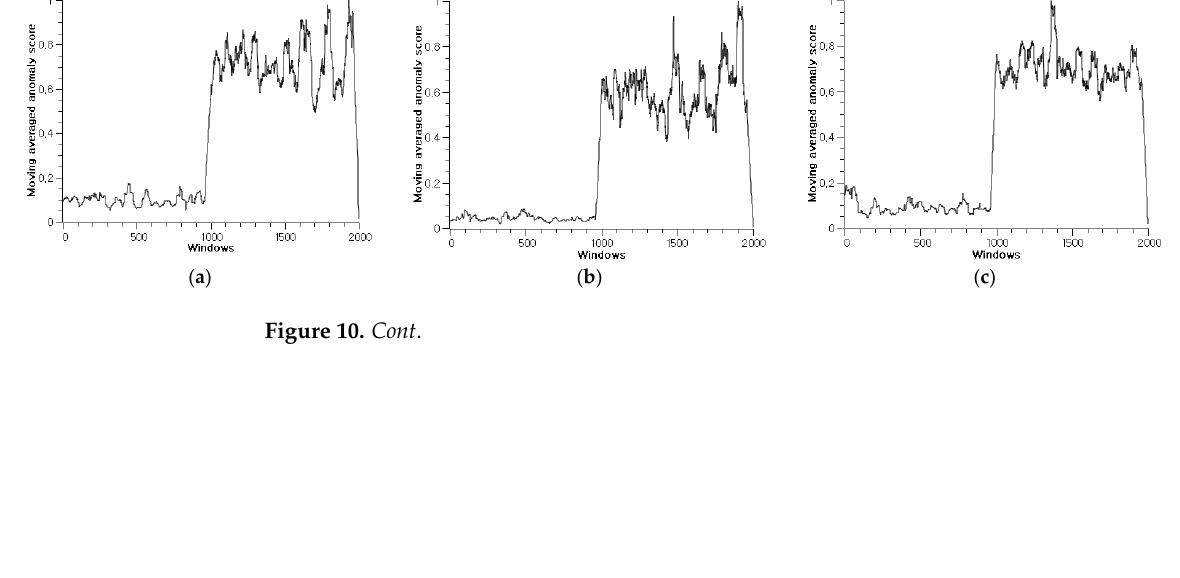
Figure 9. The anomaly score of scenario 11 for healthy condition (0–1000) and faulty condition (1001–2000) windows. The score shows low values for the healthy condition until the 1000th win- dow, and the values become high for the unhealthy windows after the 1000th window. The red dashed line represents the threshold limit: ( a ) Score of standard AAE; ( b ) Moving-averaged score of standard AAE; ( c ) Score of RaPP AAE; ( d ) Moving averaged score of RaPP AAE.